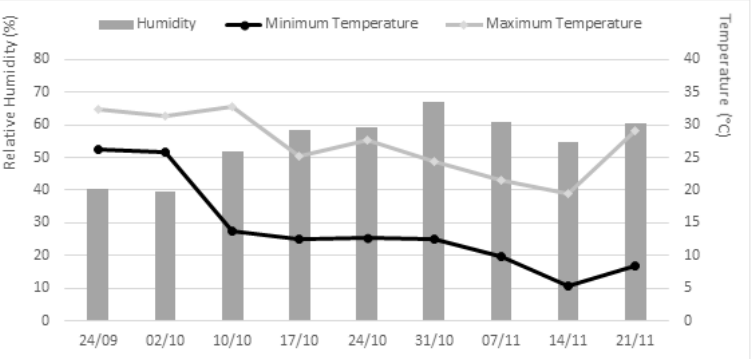
Figure 3. Temperatures and relative humidity values in the greenhouse during the experiments.